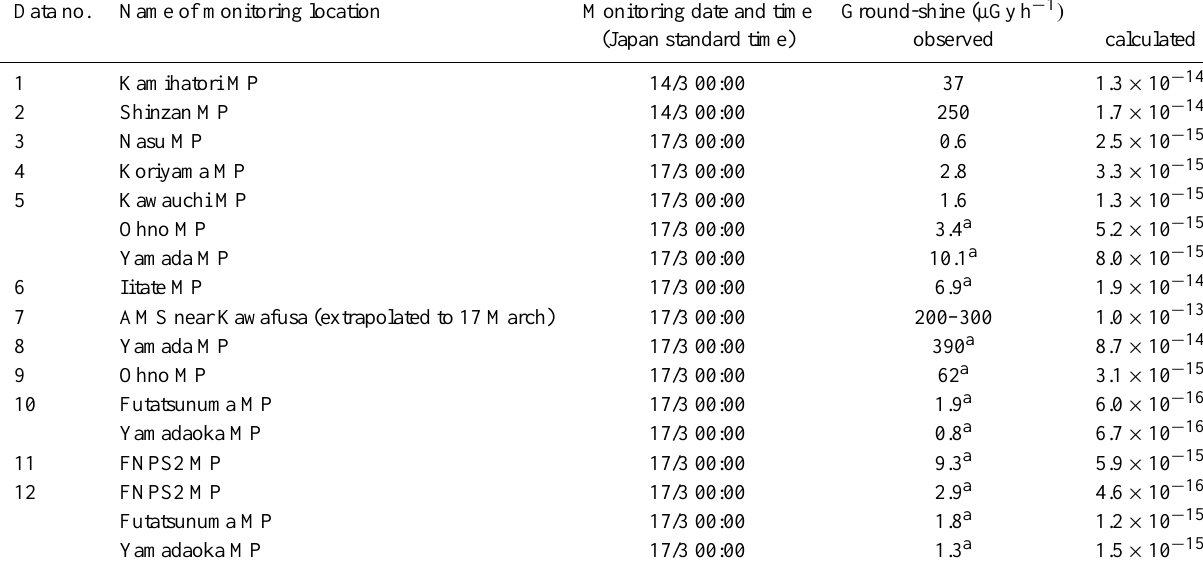
Table 3. Air dose rate monitoring data used for the source term estimation. The locations of monitoring site are illustrated in Fig. 2. The air dose rate calculations for source term estimation were carried out under the assumption of unit release rate (1Bqh − 1 ) . Data